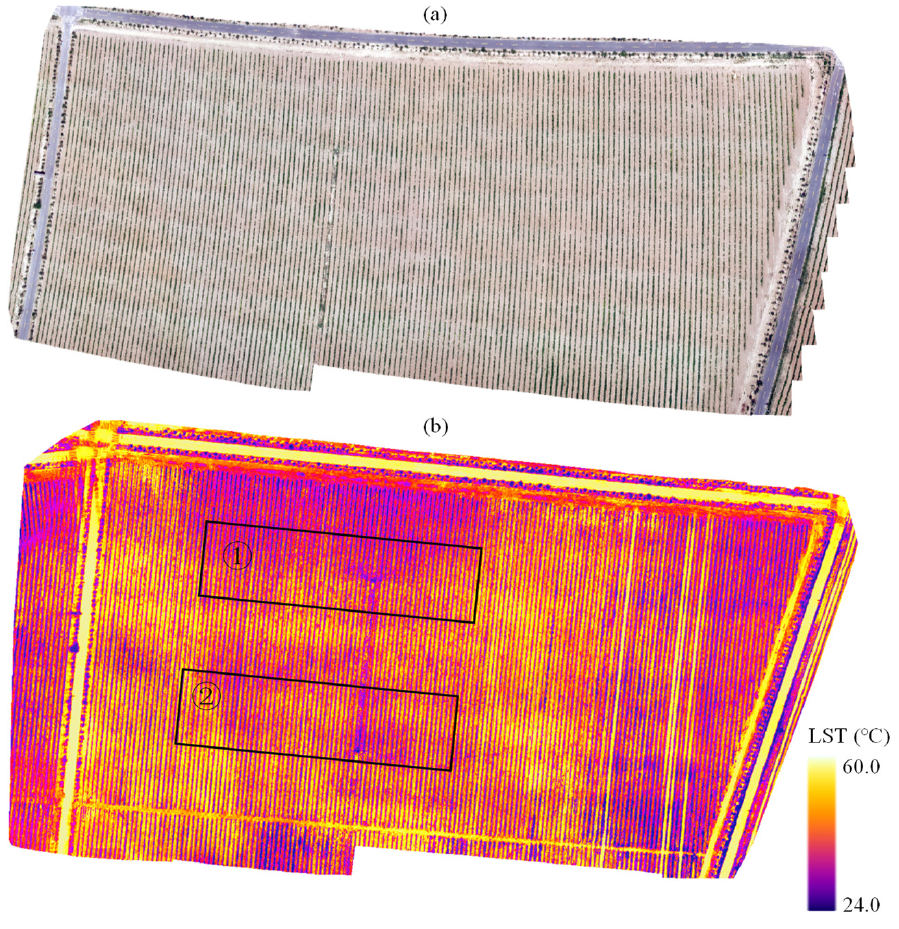
Figure 5. Airborne ( a ) visible-light and ( b ) thermal image obtained over the study vineyard at 13:00 on 6 June 2019. The black rectangle marked were set up for statistics.